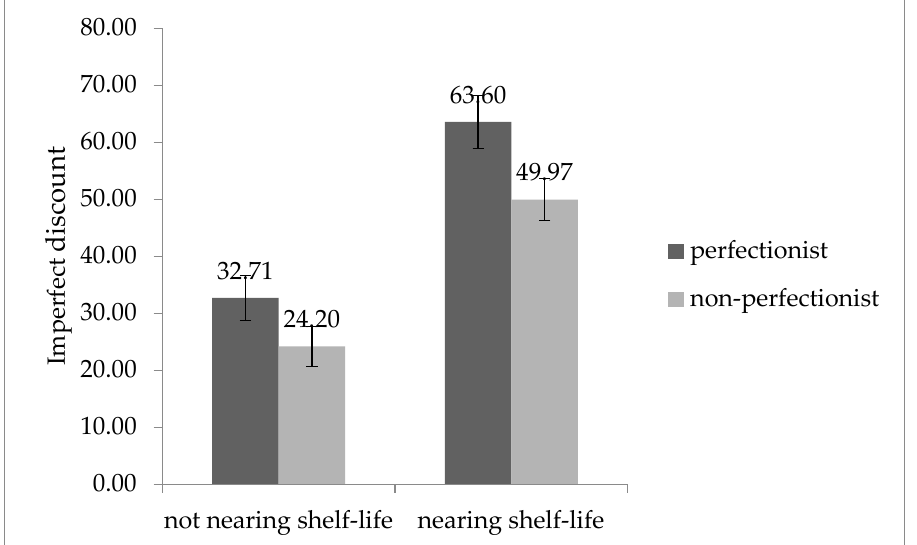
Figure 1. Willingness to pay for products nearing shelf life end or not according to perfectionists or non-perfectionists.